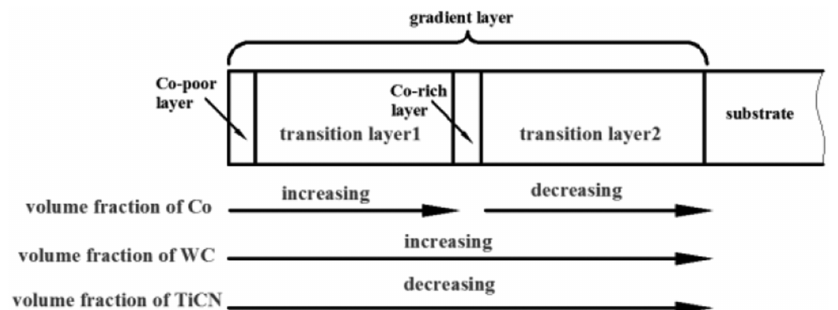
Figure 3: Model of three-component